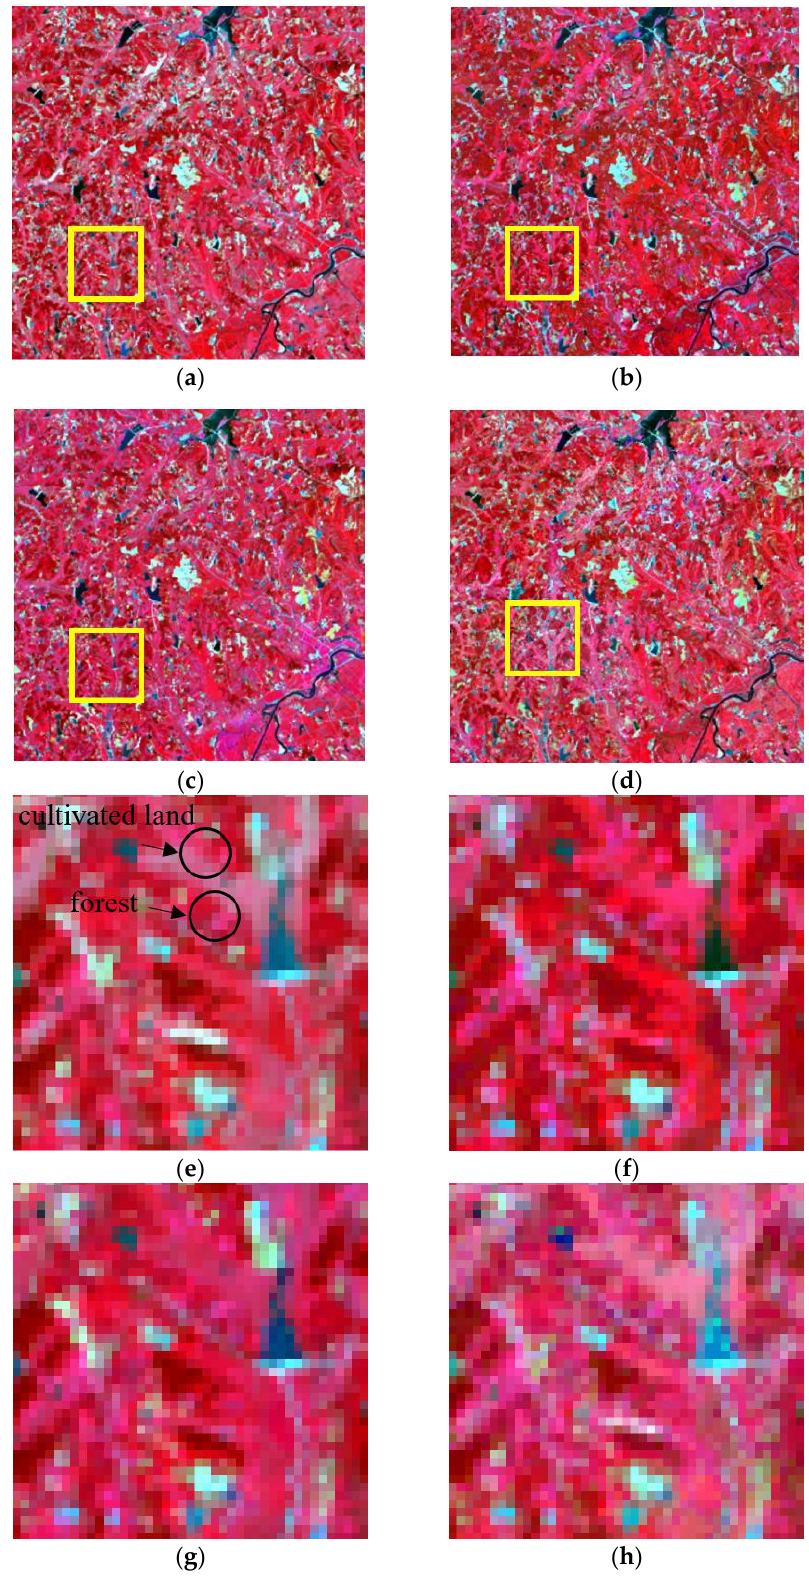
Figure 14. The fusion results of study area 3, ( a ) Actual Landsat image, ( b ) STARFM, ( c ) ESTARFM, ( d ) I-ESTARFM, ( e ) Actual Landsat image (highlight region), ( f ) STARFM (highlight region), ( g ) ESTARFM (highlight region), ( h ) I-ESTARFM (highlight region).